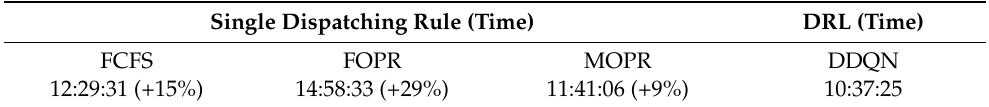
Figure 10. Comparison of makespans obtained with dispatching rules and proposed method. Table 4. Makespan mean value comparison in Case